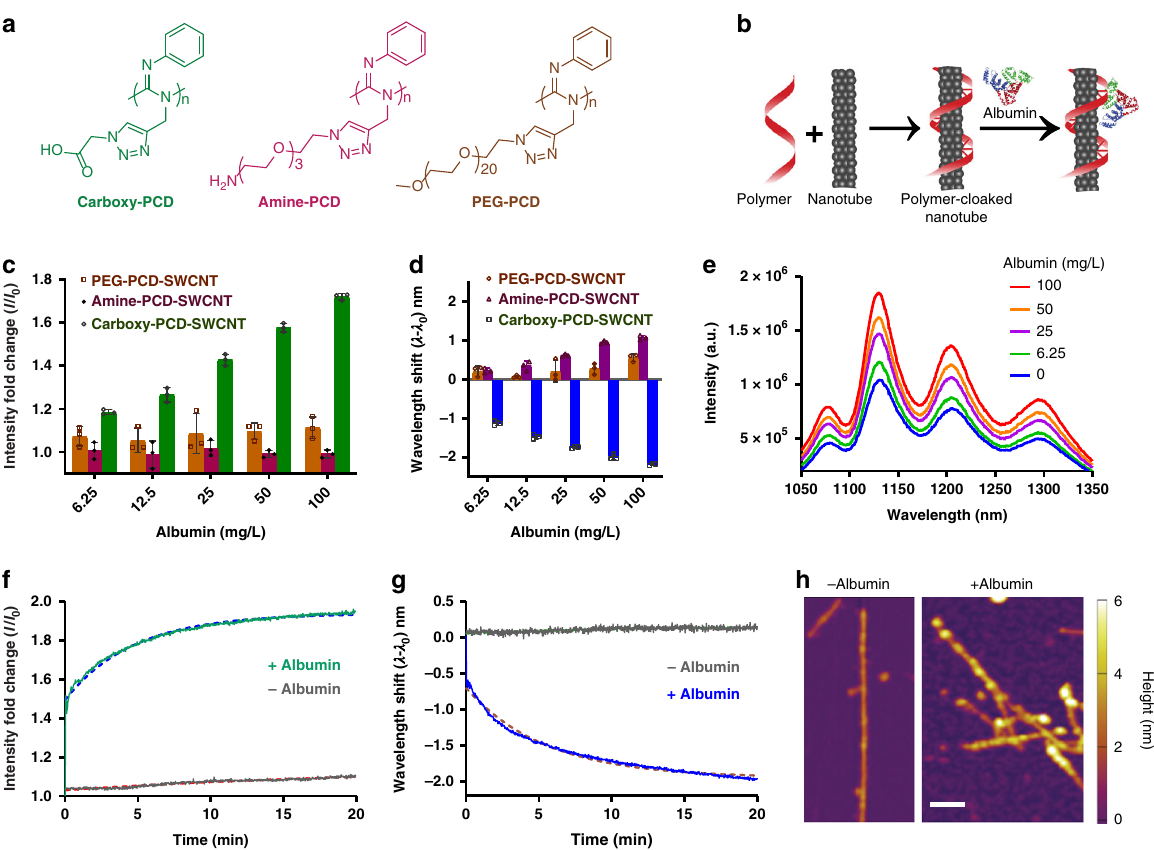
Fig. 1 Optical nanosensor for albumin detection. a Schematic showing PCD structures. b PCD-SWCNT complex formation and its interaction with albumin protein. c Emission intensity response of the PCD-SWCNT complexes ((9, 4) chirality) to albumin. d Emission wavelength response of the PCD-SWCNT complexes to albumin ((9, 4) chirality). e Photoluminescence emission spectra of carboxy-PCD-SWCNT complexes upon addition of albumin (concentration increasing from bottom to top). f Response curve of emission intensity of carboxy-PCD-SWCNT complexes ((9, 4) chirality) to albumin. g Response curve of emission intensity of carboxy-PCD-SWCNT complexes to albumin ((9, 4) chirality). h Atomic fore microscopy height pro fi le images of carboxy-PCD-SWCNT complexes and the same complexes upon exposing to albumin. Scale bar indicates 50 nm. Error bars represent standard deviation for n = 3 technical